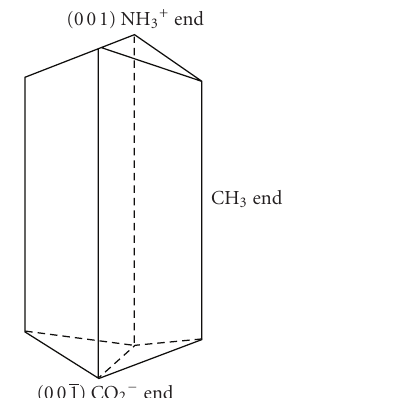
Figure 3: Packing arrangement of L-threonine as viewed down the b -axis.